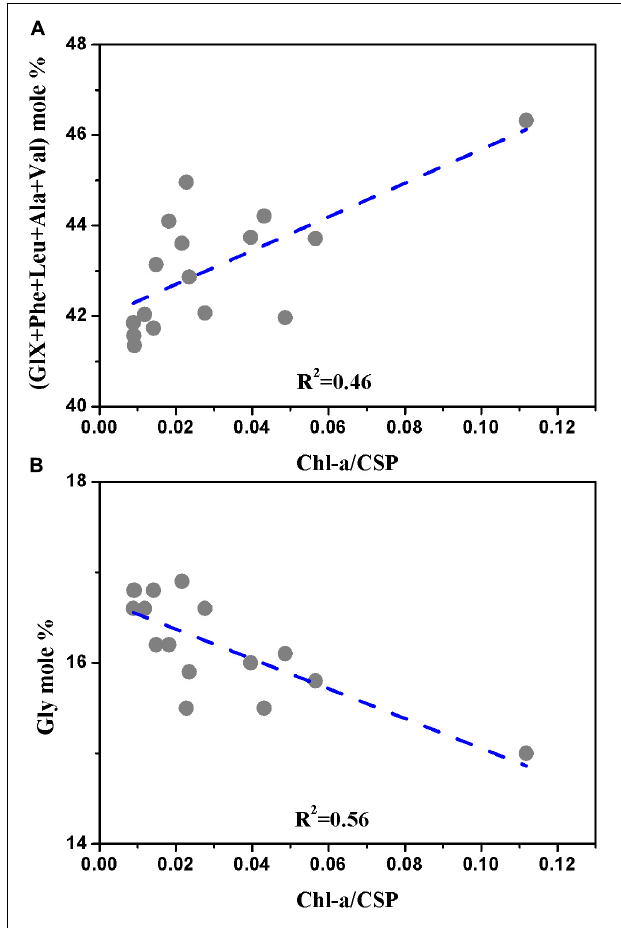
FIGURE 8 | (A) (GlX+Phe+Leu+Ala+Val) mole% vs. Chl a /CSP; and (B) Gly mole% vs. Chl a